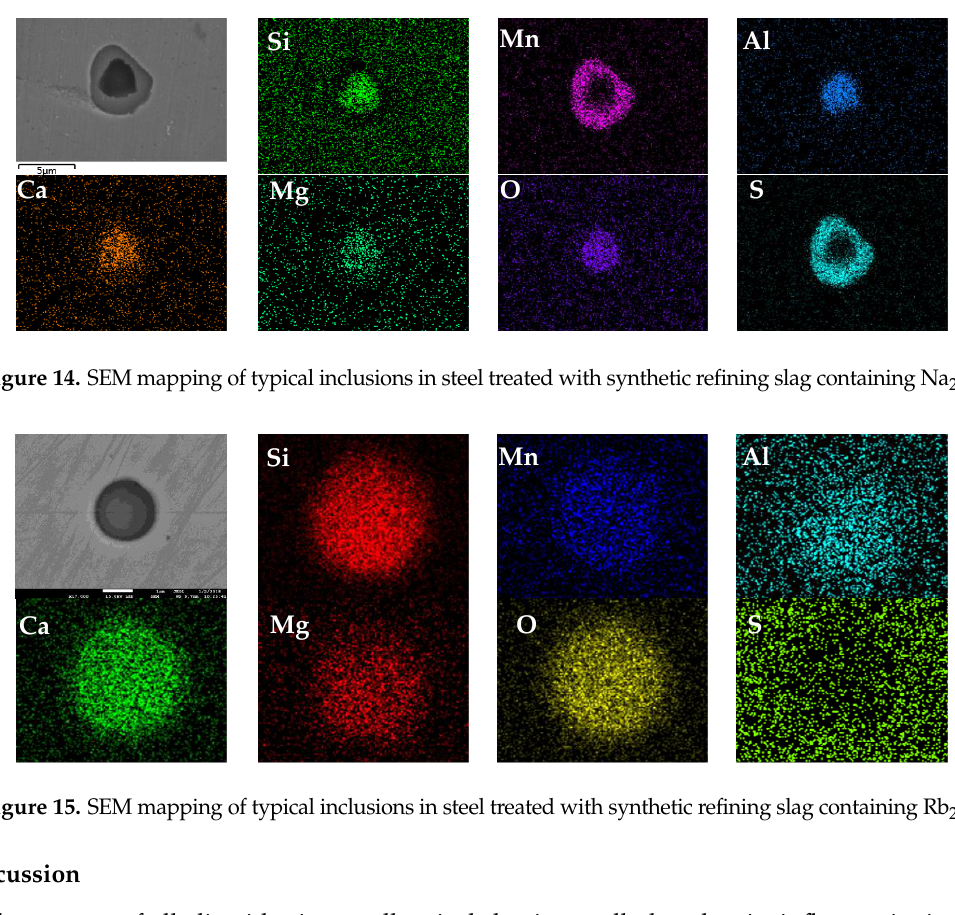
Figure 13. SEM mapping of typical inclusions in normal experiment heat.